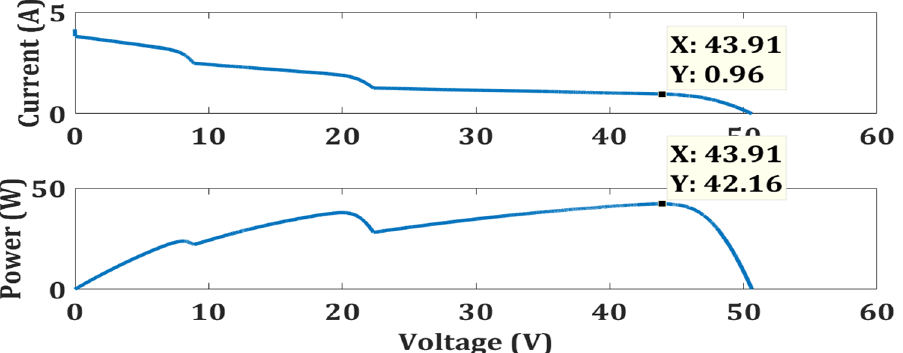
Figure 9. The characteristic curve of a 4S PV array under strong partial shading.